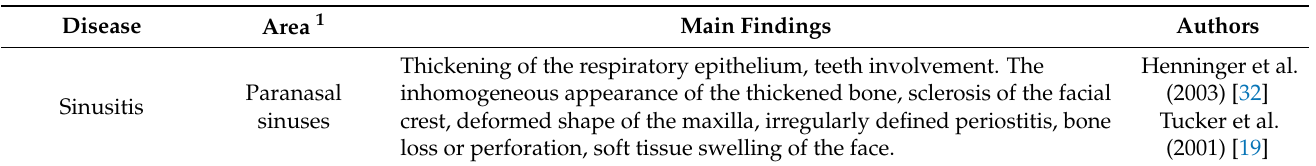
Table 1. The selected diseases of the equine head and neck area and their main findings diagnosed based on computed tomography